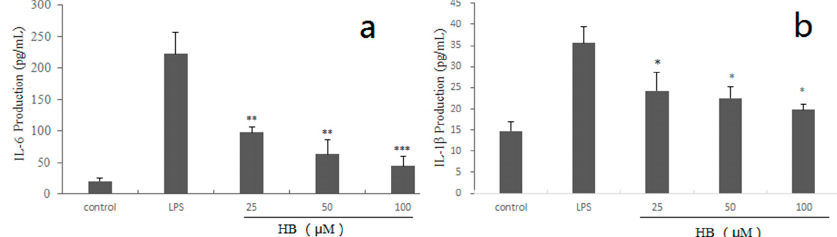
Figure 4. Effects of HB on LPS-induced production of IL-6 ( a ) and IL-1 β ( b ) in RAW 264.7 Cells. RAW 264.7 Cells were pretreated with different concentrations of HB (25, 50, and 100 μ M) for 1 h before treatment with 1 μ g/mL LPS. After incubation for 18 h, the IL-6 and IL-1 β production analysis was detected by ELISA kits. The values are presented as means ± SD of three independent experiments. * p < 0.05, ** p < 0.01, *** p < 0.001, compared to the LPS-treated group.